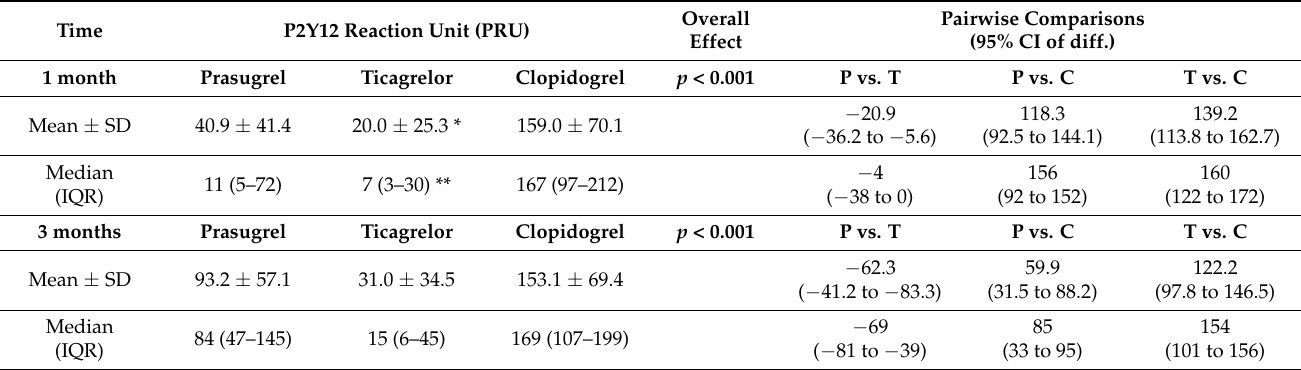
Table 2. Pharmacodynamics comparison between oral P2Y12 inhibitors.